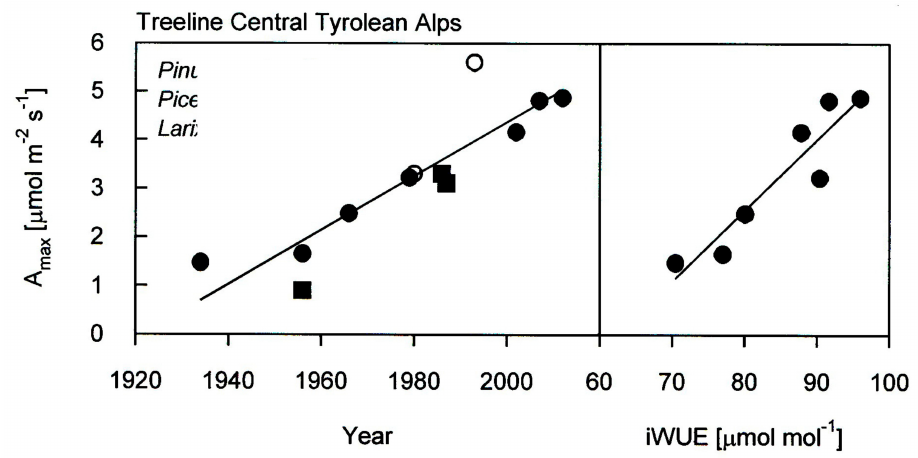
Figure 5. Temporal variation in maximum net CO 2 uptake rate at ambient CO 2 (A max ) of Pinus cembra (solid circles), Picea abies (solid squares), and Larix decidua (open circles) between 1925 and 2013 (left), and the relationship between A max and tree-ring derived intrinsic water-use e ffi ciency (iWUE) obtained for Pinus cembra at the treeline in the Central Tyrolean Alps. Compiled after